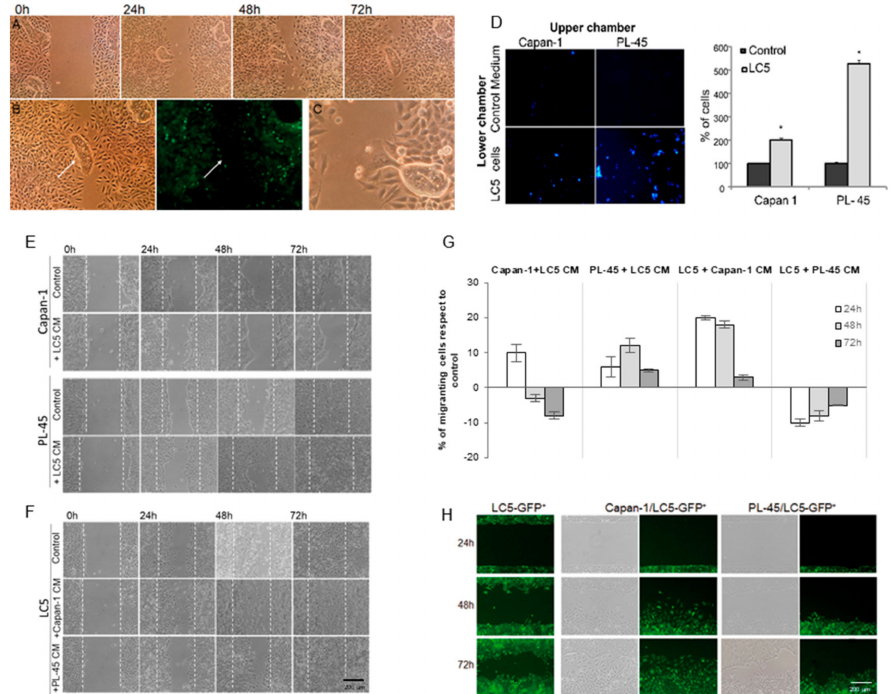
Figure 4. Migration and invasion assays in coculture conditions. Wound-healing assay in direct cocultures of LC5-GFP + and Capan-1 tumor cell line. Photographs taken after 24, 48, and 72 h of coculture are shown ( A ). Images of cell migration in phase contrast (left) and fluorescence microscope (right) are presented. The white arrow points to a group of tumor cells migrating like a packed sheet ( B ). Detail of tumor cells invading the wound: enlarged figure depicts tumor cells that are polarized with cytoplasmic protrusions facing the wound in an amoeboid movement ( C ). Transwell migration assay: representative photographs of Capan-1 and PL-45 cells that have invaded into the 8 µ m pore membrane filter and histograms of migrated tumor cells compared to control (100%) are shown. Migrated cells were quantitated by counting cells in 10 random fields in each sample. Data are presented as mean ± SD from three independent experiments (* p < 0.0001) ( D ). Wound scratch assay: treatment of pancreatic tumor cell lines with conditioned medium (CM) from fibroblasts. Control: tumor cells in growth medium ( E ). Treatment of LC5 fibroblasts with conditioned medium (CM) from Capan-1 or PL-45 pancreatic tumor cell lines. Control: LC5 fibroblasts in growth medium ( F ). Bar graph shows the percentage of migratory cells with respect to their controls in wound scratch assays. Migration was quantified by counting the 10 cells furthest from the edge of the wound in 5 random fields from 3 different photographs. Data are presented as mean ± SD ( G ). Wound-healing assay in 2 well Ibidi culture-insert. First column: images in fluorescence microscope of cell migration at 24, 48 and 72 h of LC5-GFP+ cells seeded on both sides of the insert. Columns 2 and 3: images of cell migration in phase contrast (column 2) and fluorescence microscopes (column 3) of Capan-1 tumor cells seeded in the upper side of the image and LC5-GFP + seeded in the lower side. Columns 4 and 5: images of migration with PL-45 tumor cells in the upper side and LC5-GFP+ in the lower side ( H ). The green color indicated GFP-transfected fibroblasts. Scale bar indicates 200 µ